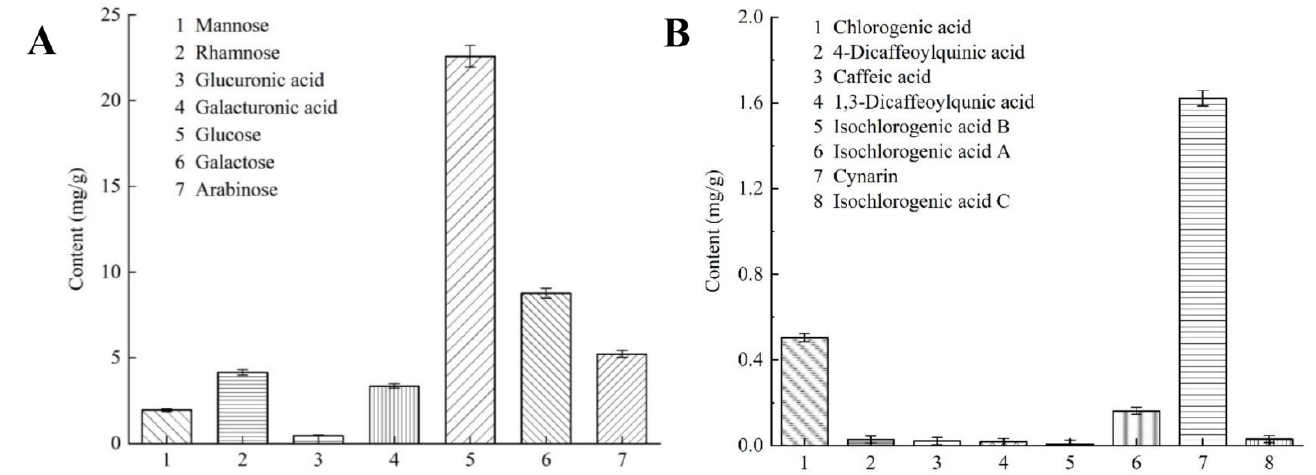
Figure 4. Concentrations of monosaccharides and alduronic acid in carbohydrates ( A ) and concentrations of eight phenolic acids in polyphenols ( B ).